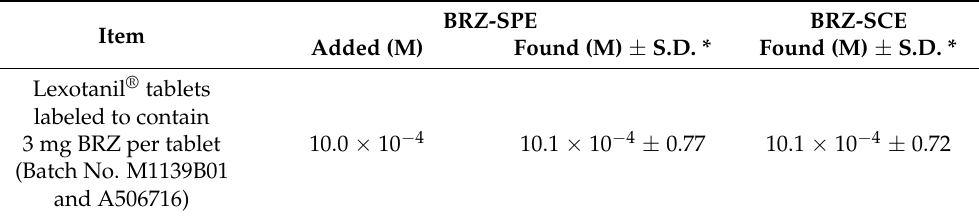
Table 4. Results obtained for the analysis of the tablet form using the fabricated membrane sensors at 25 ◦ C.